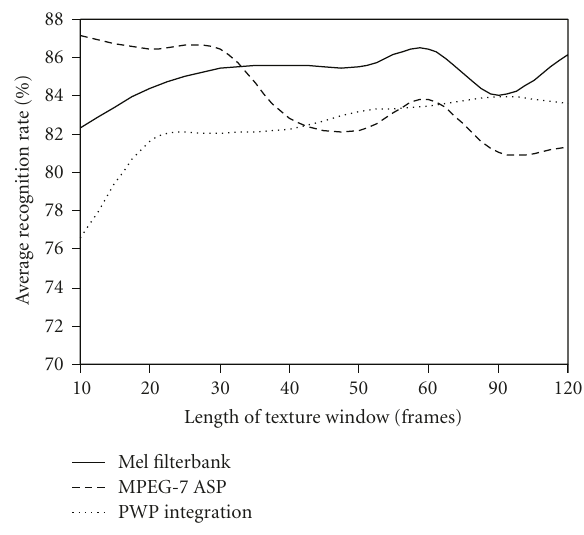
Figure 4: Average recognition rate as a function of the length of texture window with respect to each feature